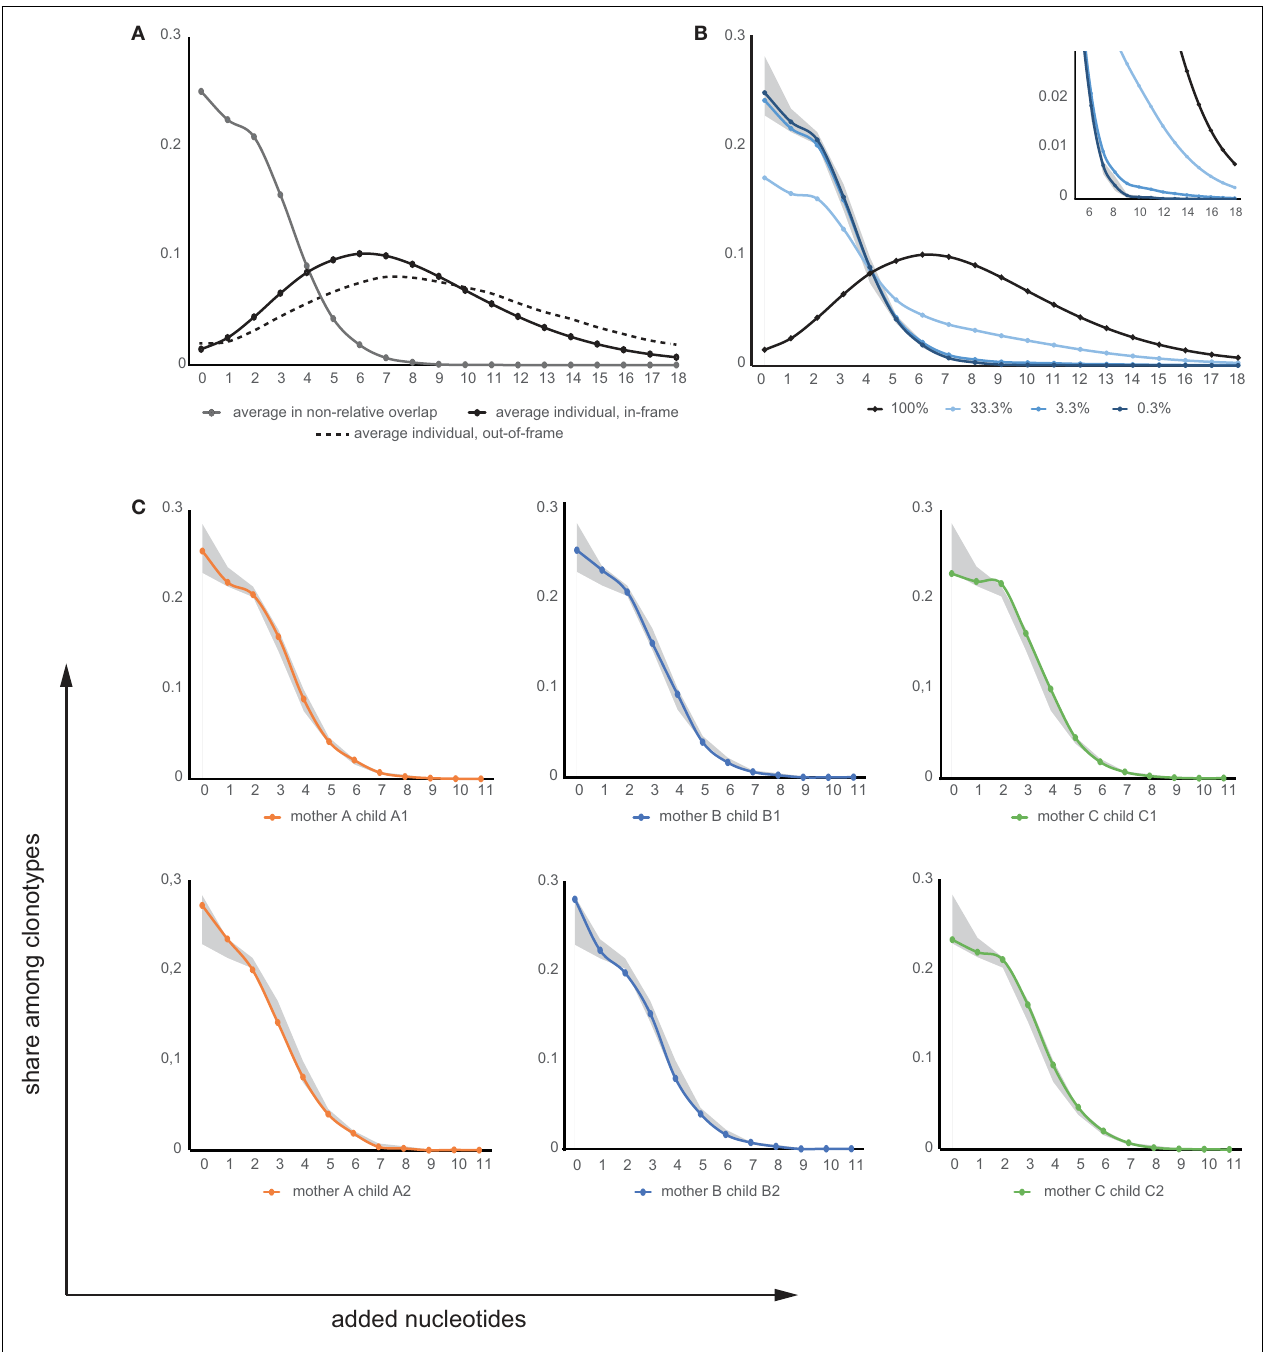
(gray; equivalent to near-zero contribution to shared clonotypes) and for any individual repertoire (black; equivalent to 100% contribution to shared clonotypes), mixed in different proportions. Lines represent model input where mature-microchimericTCR beta is equal to 100, 33, 3.3, or 0.3% of shared clonotypes. Shaded region shows the range for unrelated pairs. Inset shows a magnified view. (C) Added nucleotide curves forTRBV-CDR3-TRBJ variants shared in each related mother-child pair. Shaded region shows the range for unrelated